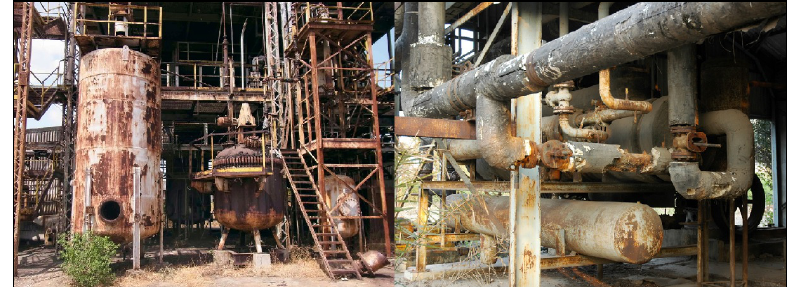
Figure 7 – Elements of the UCIL pesticide plant in Bhopal Рис . 7 – Завод по производству пестицидов UCIL в Бхопале Slika 7 – Elementi postrojenja za proizvodnju pesticida UCIL u